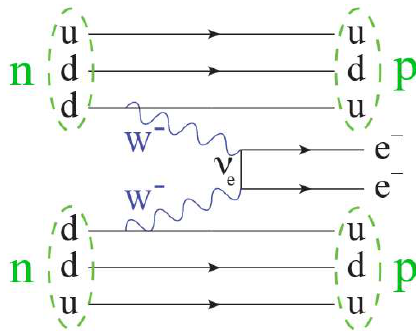
Figure 1. Majorana neutrinoless double beta decay 4 , not seen experimentally.